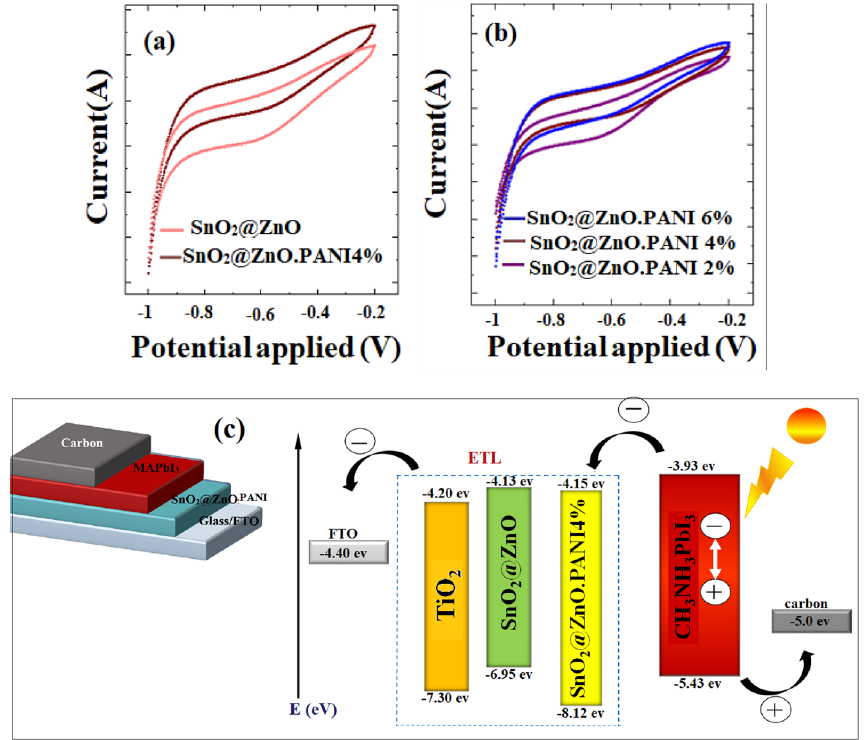
Figure 9. Cyclic voltammetry graphs of ( a ) SnO 2 @ZnO nanocomposite and SnO 2 @ZnO.PANI 4% nanocomposite, ( b ) different volume ratios of SnO 2 @ZnO.PANI (2%, 4%, and 6%) nanocomposite, and ( c ) Energy level diagram for all materials used in PSCs fabrication.